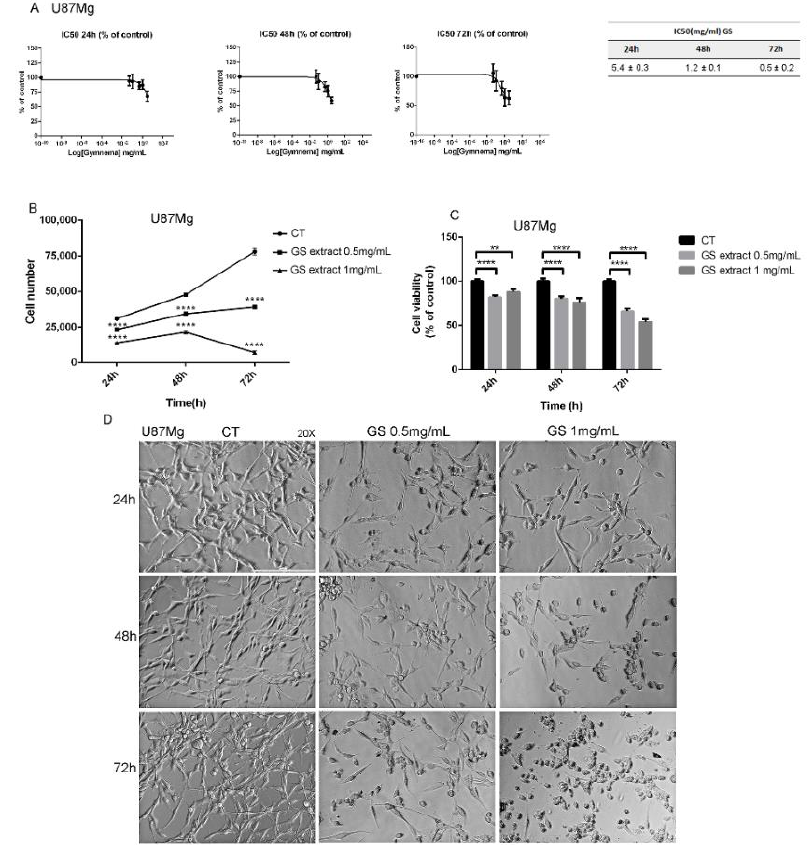
Figure 1. ( A ) IC50-values of U87Mg cells after 24, 48, and 72 h of incubation with GS extract 0.05, 0.1, 0.5, 1 and 3 mg/mL and DMSO 0.3% as vehicle control, respectively. ( B ) Time- and dose-dependent growth inhibition of GS-treated U87Mg cells. DMSO 0.3% was used as vehicle control. ( C ) Cytotoxic effect of GS 0.5 and 1 mg/mL at 24, 48, and 72 h post-treatment on U87Mg cell line. DMSO 0.3% was used as vehicle control. ( D ) Morphological changes of U87Mg human glioblastoma cells after 24, 48, and 72 h of exposure to GS 0.5 and 1 mg/mL. DMSO 0.3% was used as vehicle control. Magnification 20 × . For all the experiments, values are the means ± SEM of 3 individual determinations. Unpaired t -test, p -value < 0.05. According to GraphPad Prism, ** p -value 0.001 to 0.01 (very significant), **** p -value < 0.0001 (Extremely significant).